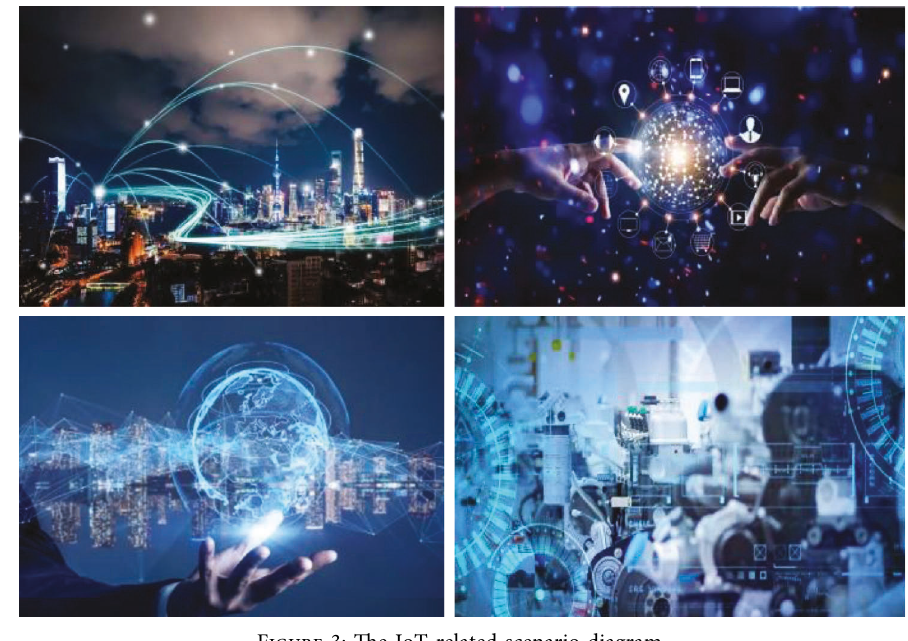
Figure 3: The IoT-related scenario